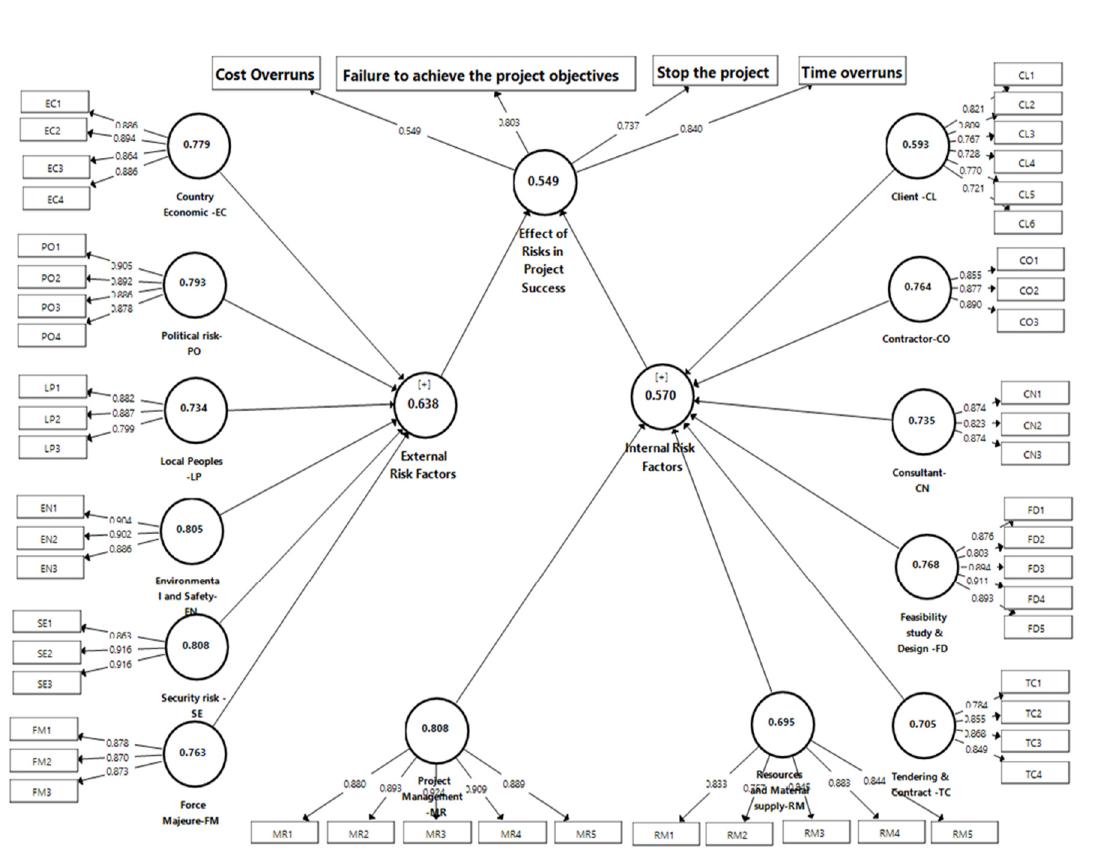
Figure 5. AVE and Factor Loading Analysis. Figure 5. AVE and factor loading